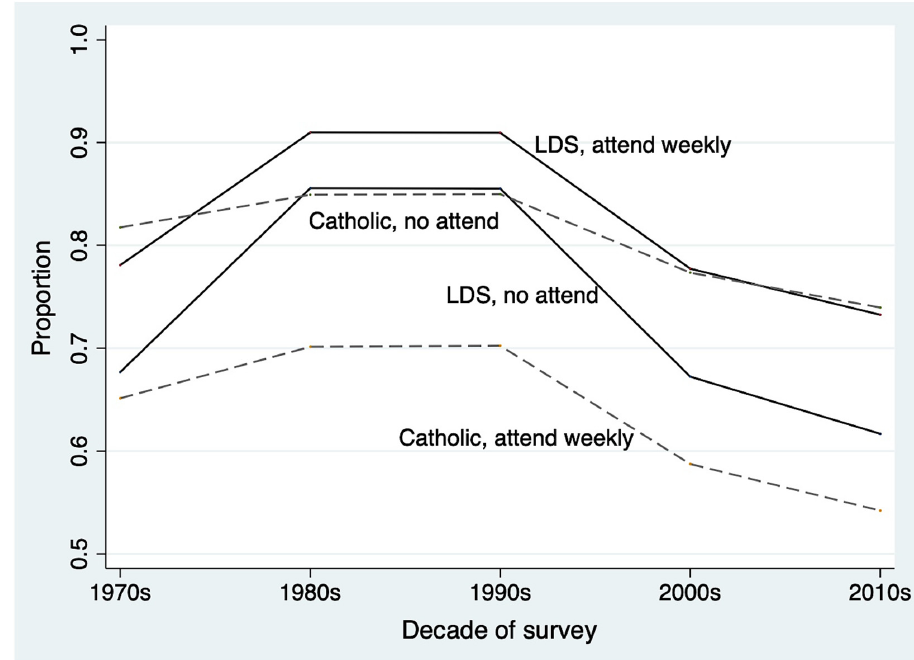
Figure 2. Proportion supporting the death penalty among Latter-day Saints and Catholics, by decade of survey and religious service attendance, General Social Surveys, 1974–2018. Note: the predicted values are based on a model that includes all the variables listed in Table 3.